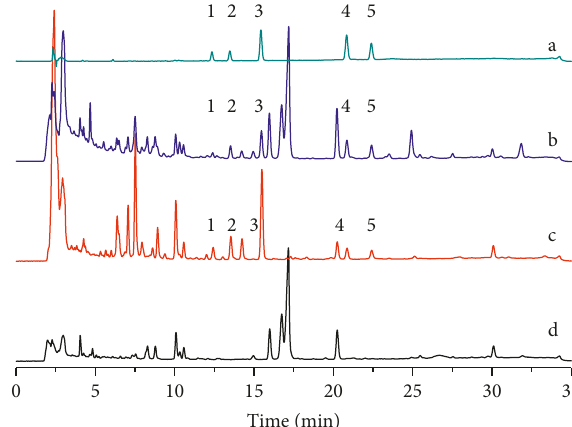
Figure 3: HPLC-UV chromatogram of (a) five triterpene acids mixed standards, (b) LDC solution B, (c) herbal Poria cocos test solution, (d) negative sample solution B with gradient program B, (1) 3-O-acetyl 16 α -hydroxytrametenolic acid, (2) dehydropachymic acid, (3) pachymic acid, (4) trametenolic acid, and (5) dehydrotrametenolic acid.